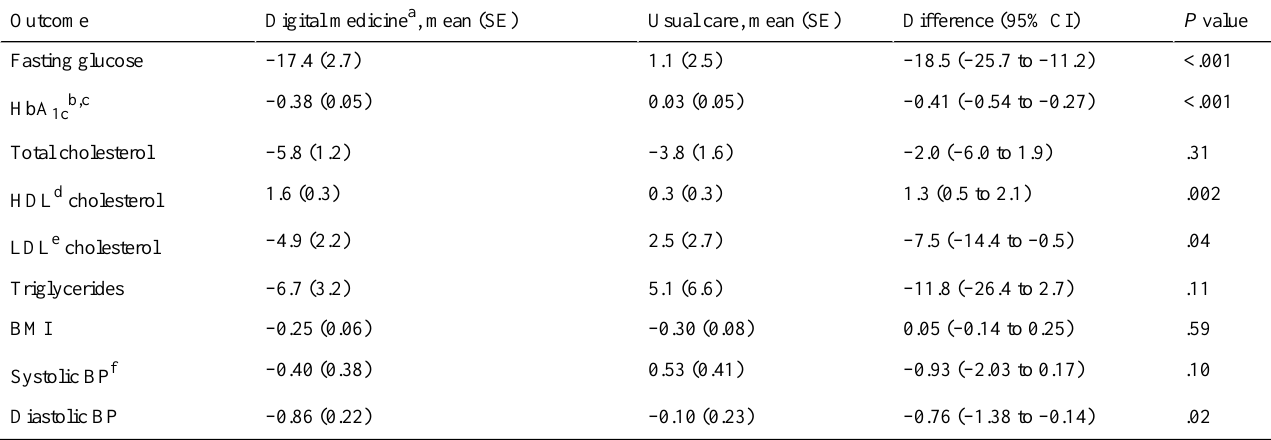
Table 11. Covariate-adjusted mean within-patient change in outcomes by